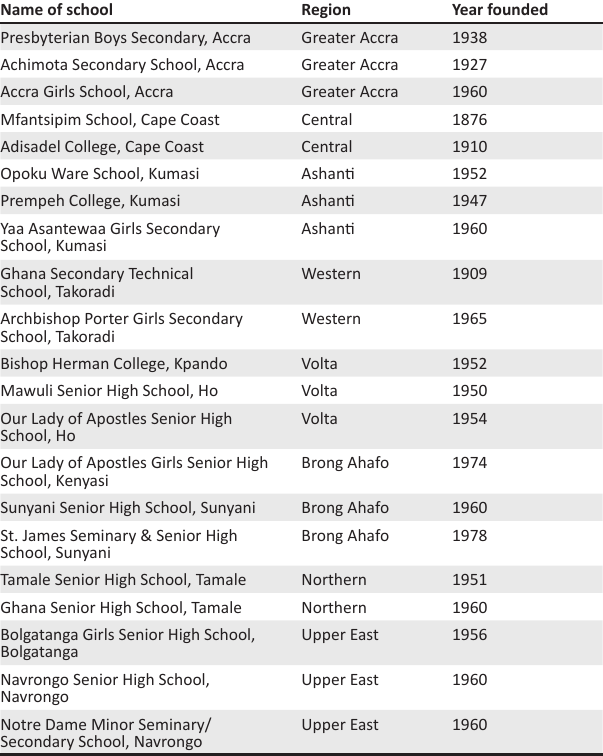
TABLE 2: List of schools surveyed in this study. Name of school